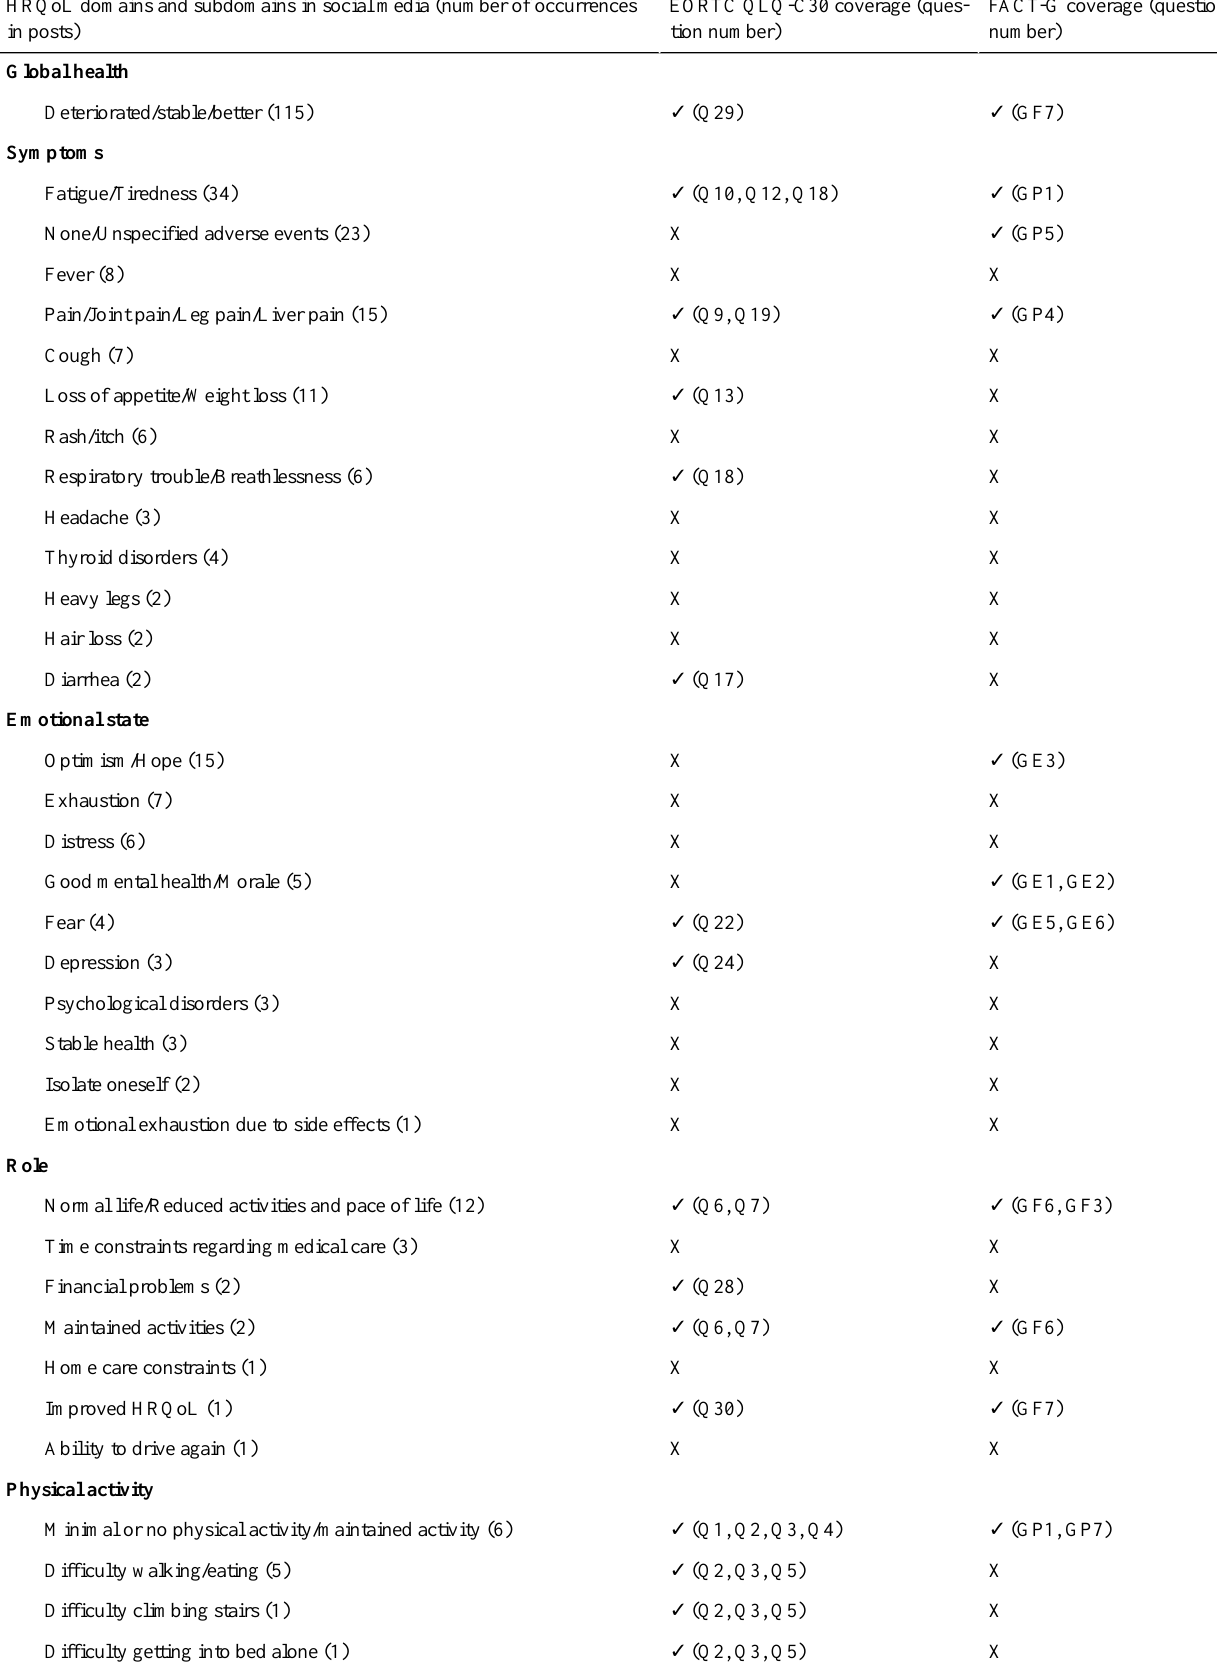
Table 3. HRQoL a subdomains in social media posts and their coverage by EORTC QLQ-C30 b and FACT-G c